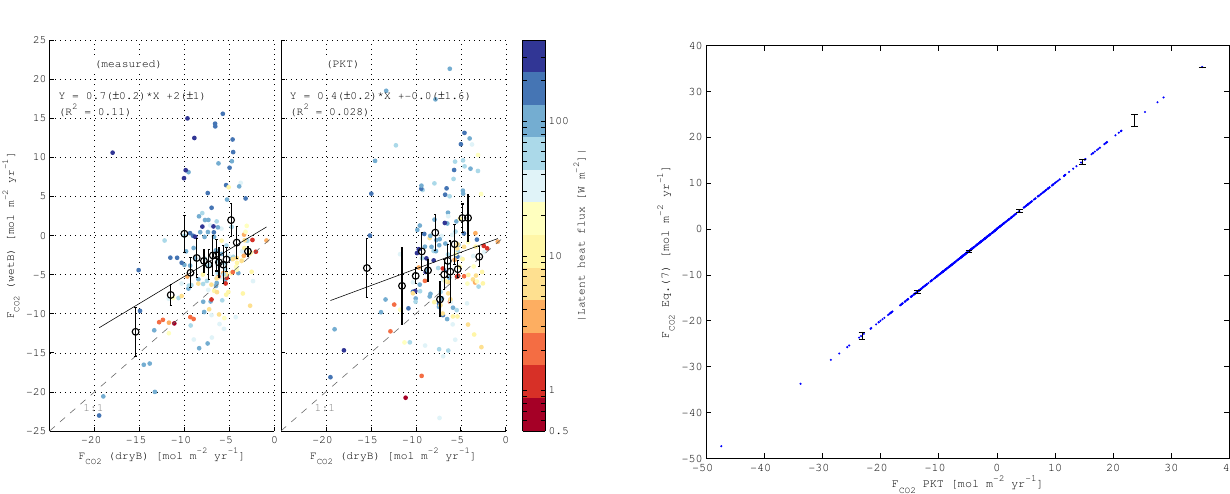
Fig. 8. Same as Fig. 7, but for wetB .